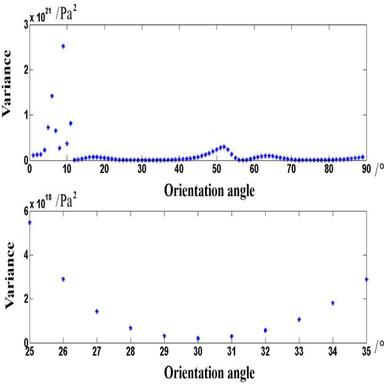
Variance of different orientation angles with an angle step of 1∘ (with rigid-body rotation).